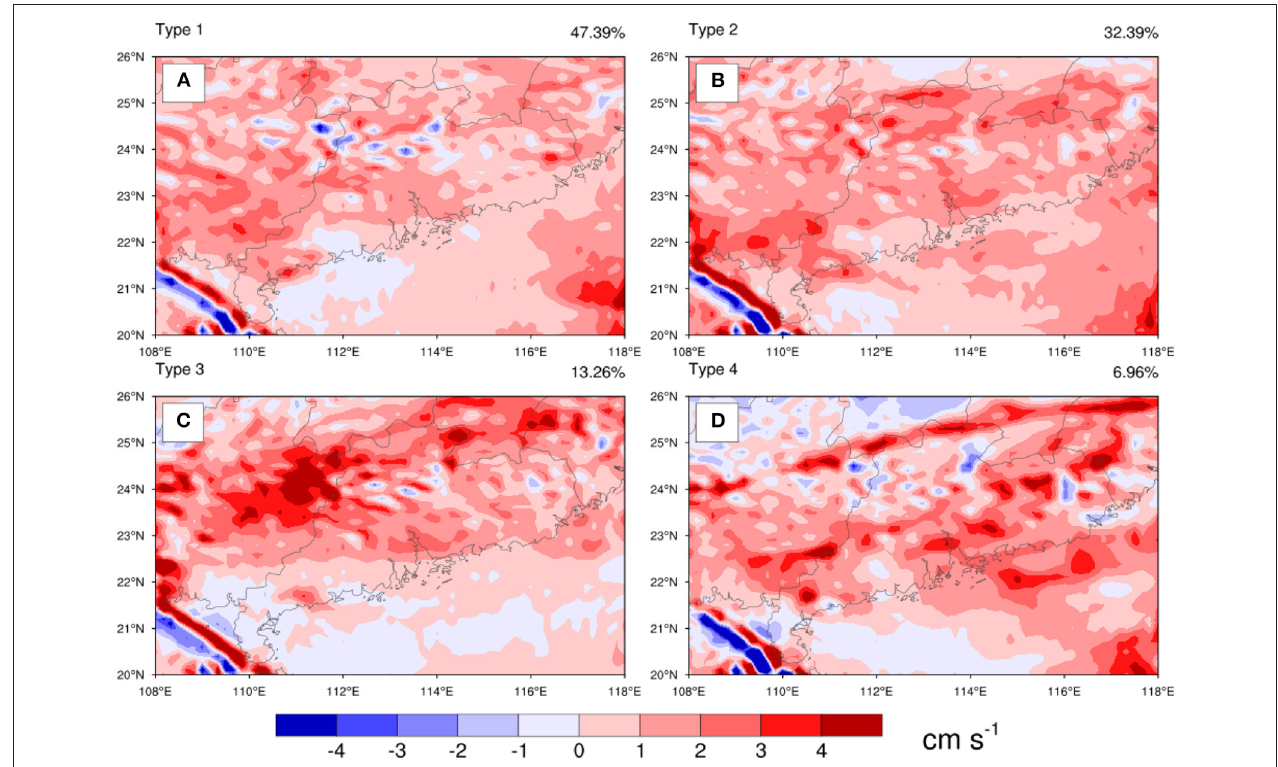
FIGURE 8 | Vertical velocity at 700hPa for four weather types: (A) Type 1, (B) Type 2, (C) Type 3, and (D) Type